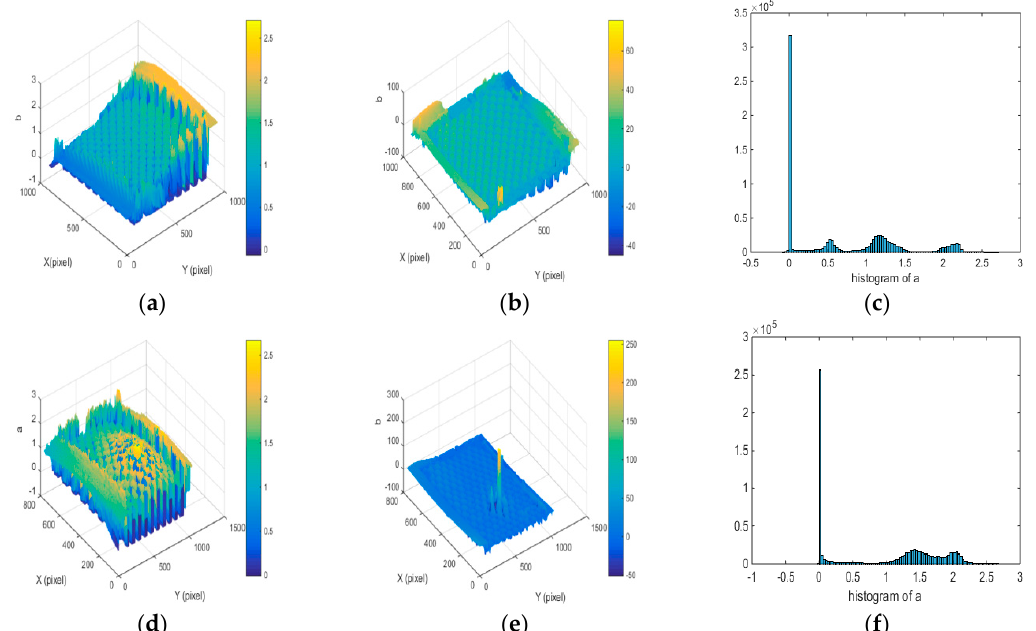
Figure 7. Results and histograms. ( a ) Surface reflectance a with right camera, ( b ) b with right camera, ( c ) histogram of a with right camera, ( d ) surface reflectance a with left camera, ( e ) b with left camera, ( f ) histogram of a with left camera.